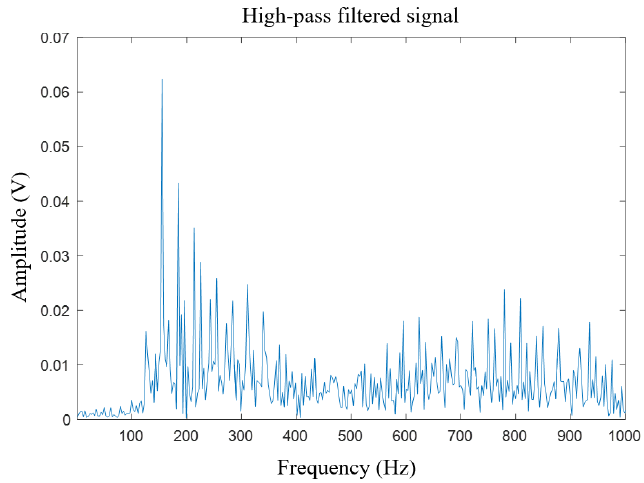
Figure 15. The envelope spectrum of high-pass filtered signal.